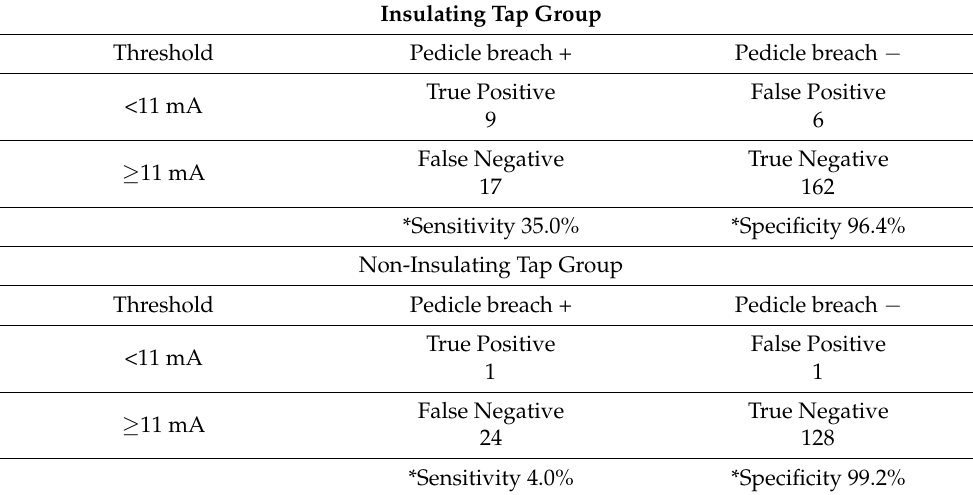
Table 4. The sensitivity and specificity of TrEMG.